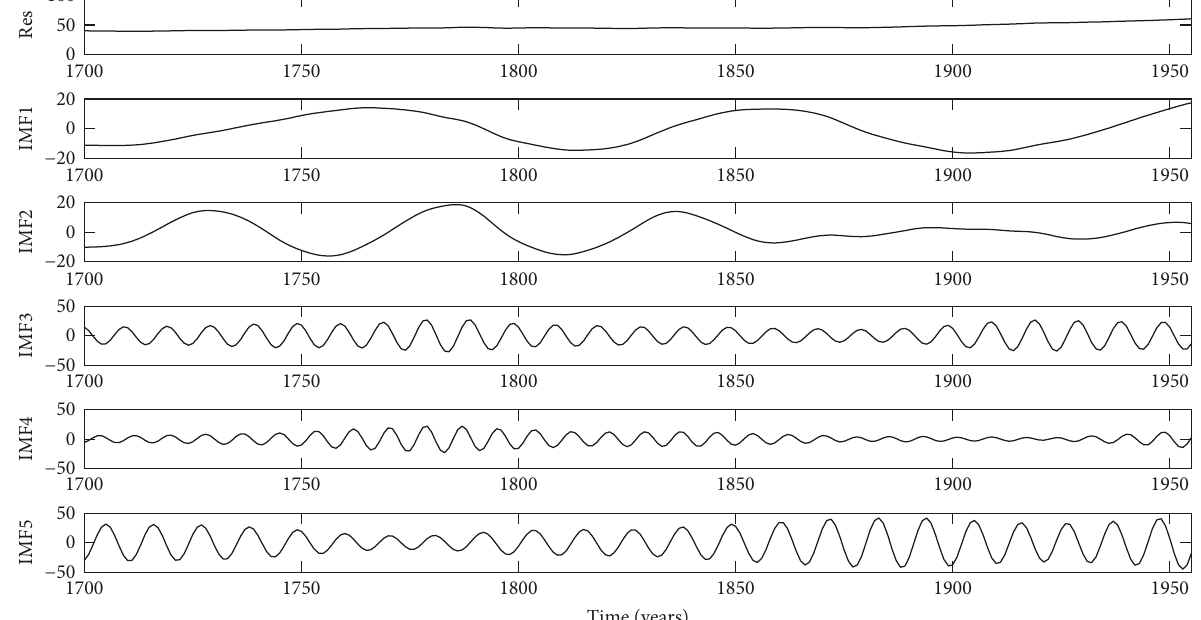
Figure 5: IMF components of sunspot number.